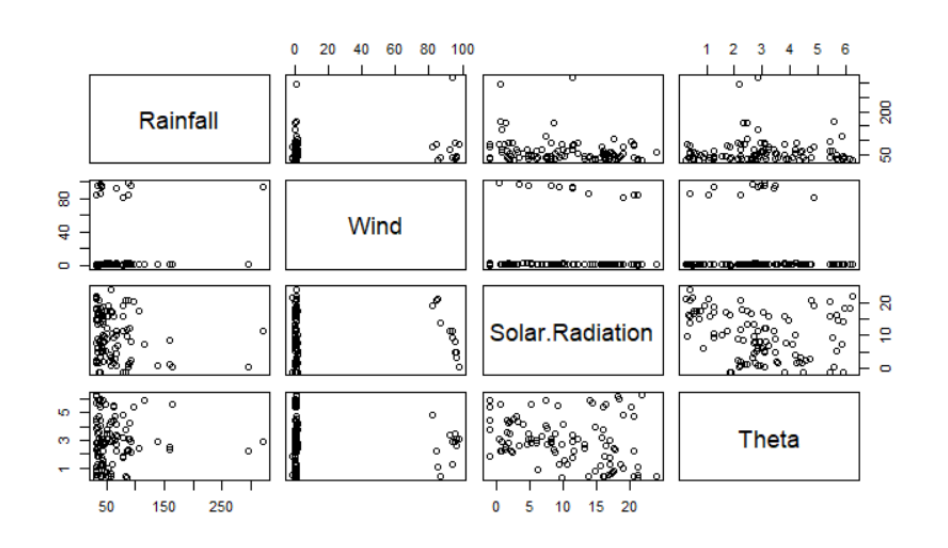
Fig. 4. Scatterplots matrix for rainfall (mm), theta ( 𝜃 𝑖 , radian), mean of wind speed (m/s), and solar radiation (MJm -2 ) at Muadzam Shah, Pahang.